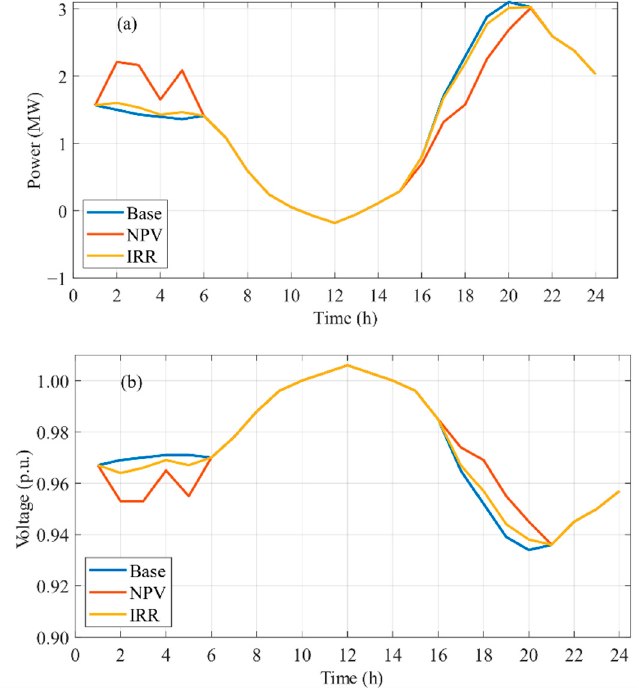
Figure 7. ( a ) Power delivered by the substation in stochastic scenario I; ( b ) voltage improvements at